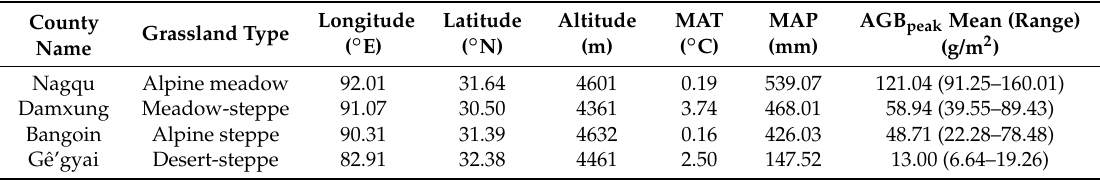
Table 1. Location, climate, and vegetation information for each sampling site. MAT, mean annual temperature; MAP, mean annual precipitation; AGB peak , peak aboveground